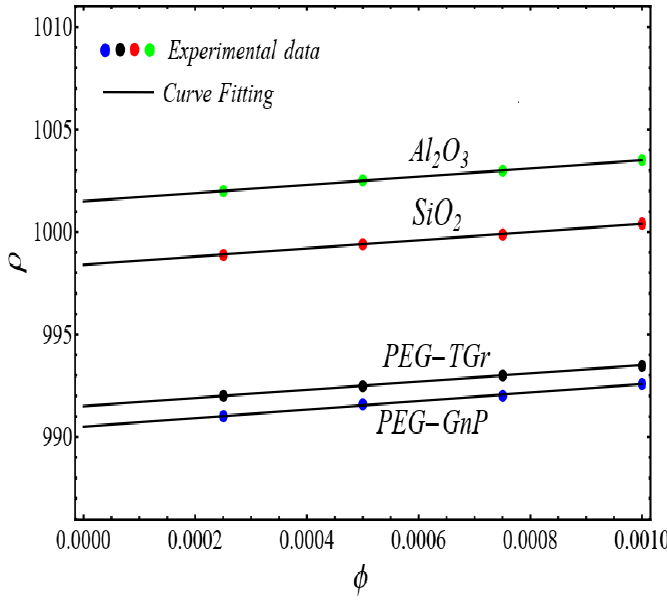
Figure 17. Fitting the Equation (5) for experimental data of schematic nanofluids.